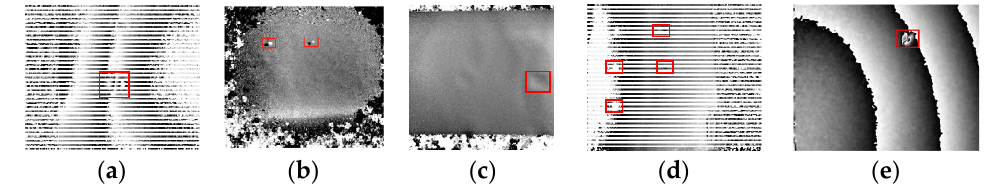
Figure 10. Experimental shearography images: ( a ) specimen 1; ( b ) specimen 2; ( c ) specimen 3; ( d ) specimen 4; ( e ) specimen 5.